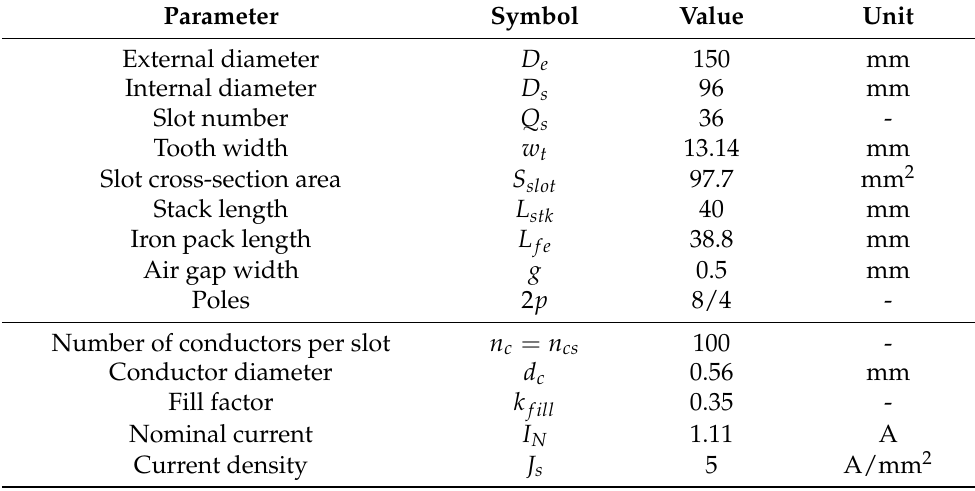
Table 1. Stator data